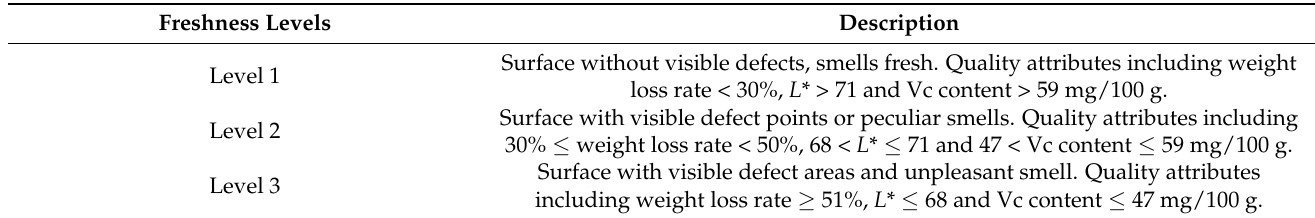
Table 1. Classification of freshness levels of mini-Chinese